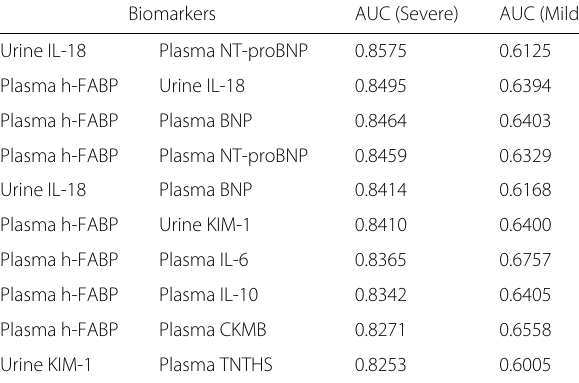
Table 5 The ten best biomarker pairs in the TRIBE-AKI study